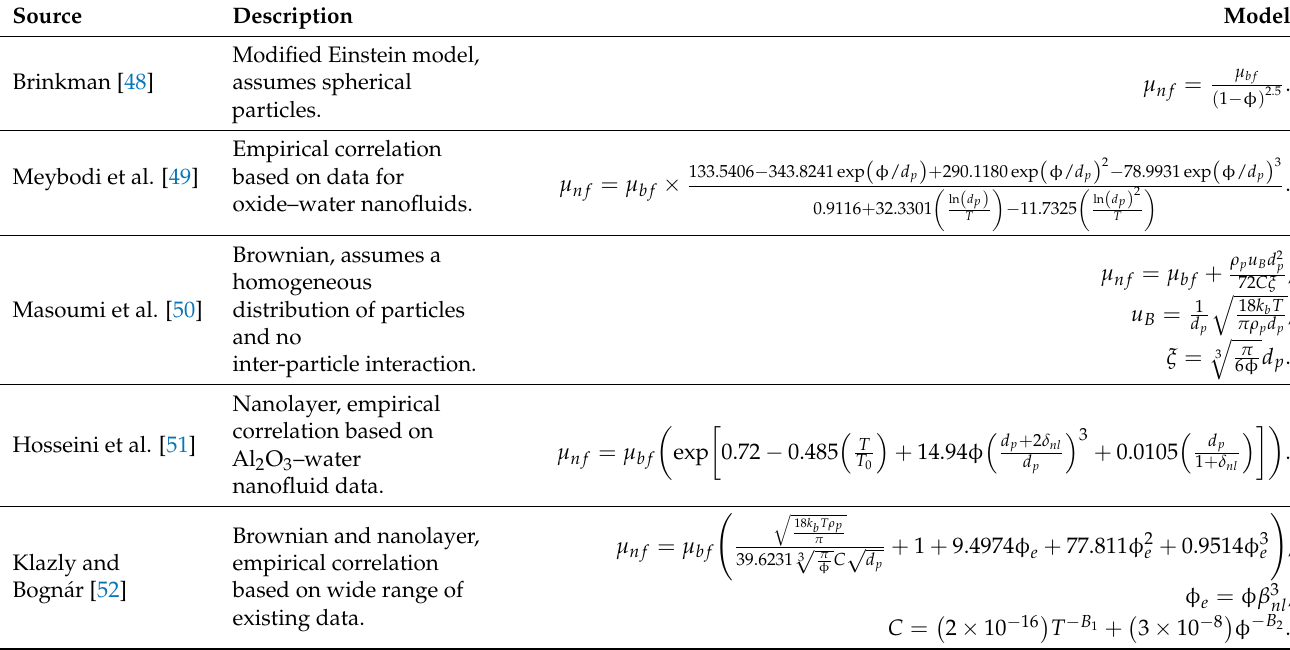
Table A3. Summary of nanofluid viscosity